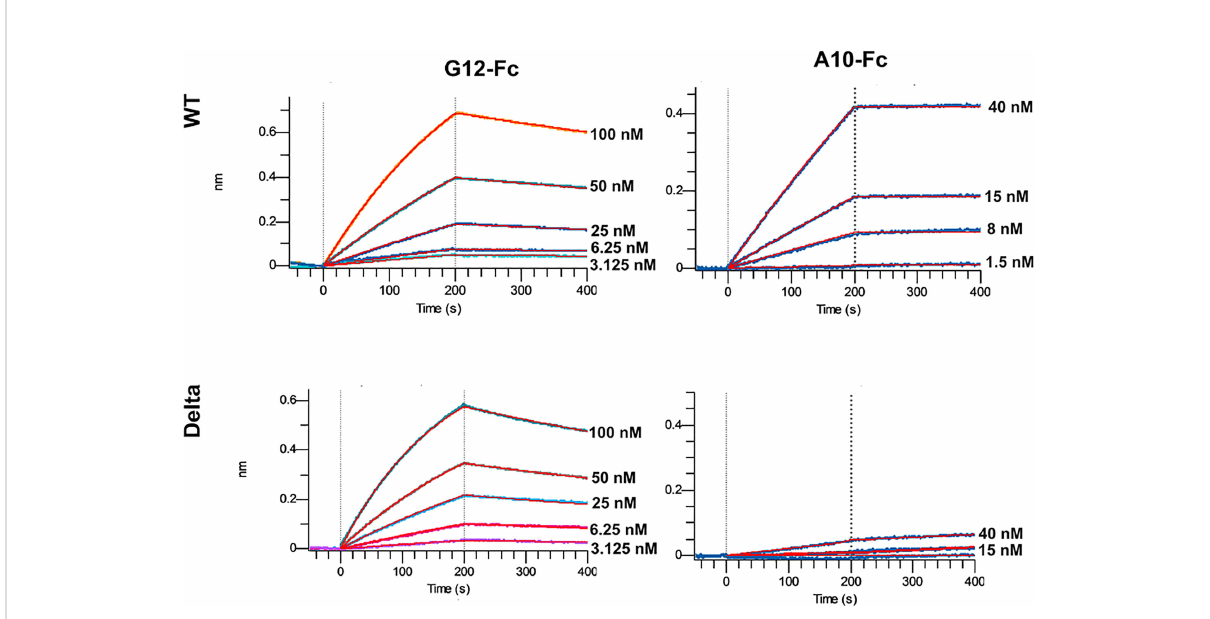
FIGURE 5 Multipoint Biolayer Interferometry (BLI) of VHH-Fc binders to WT and Delta variants